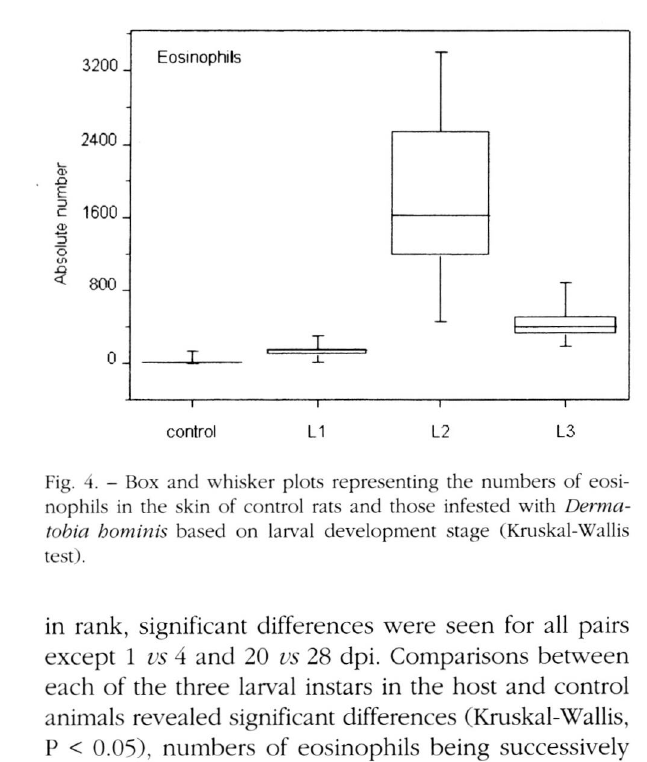
Fig. 3- - Box and whisker plots representing the numbers of eosi­ nophils in the skin of control rats and those infested with Derma- tobia hominis larvae for different periods (Kruskal-Wallis test).